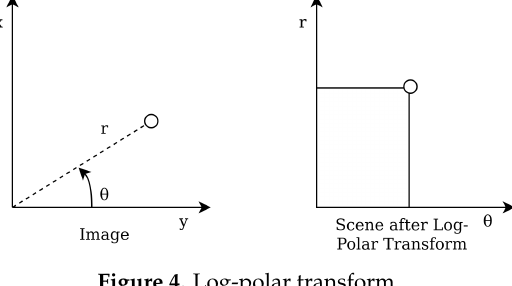
Figure 4. Log-polar